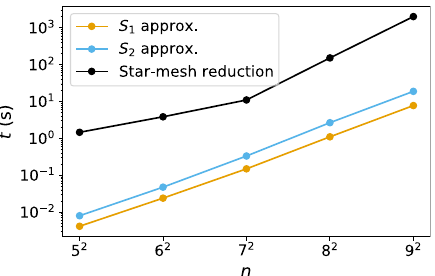
Fig. 8 The concurrence percolation threshold as a function of m for Erd ő s – Rényi (ER) networks. The relationship can be approximated with a power law, θ th ( m ) ∝ m ϕ , which is represented by the dashed black lines. The networks have size n =